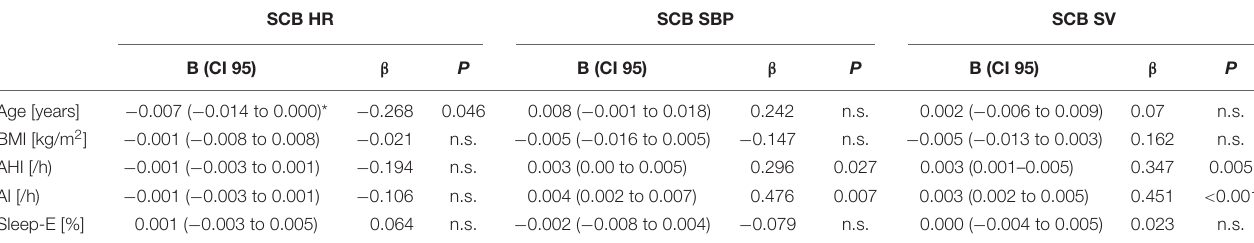
TABLE 4 | Simple regression analysis of anthropometric and sleep variables on the standardized coefficient β (SCB) of the hemodynamic parameters. SCB HR SCB SBP